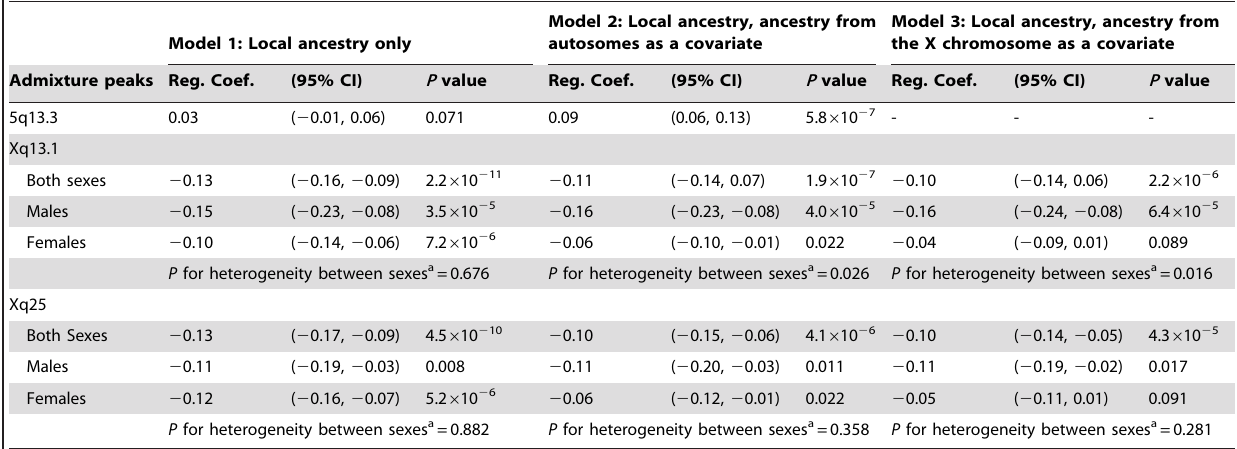
Table 3. Linear regression analysis of BMI on local European ancestry at the three admixture peaks.